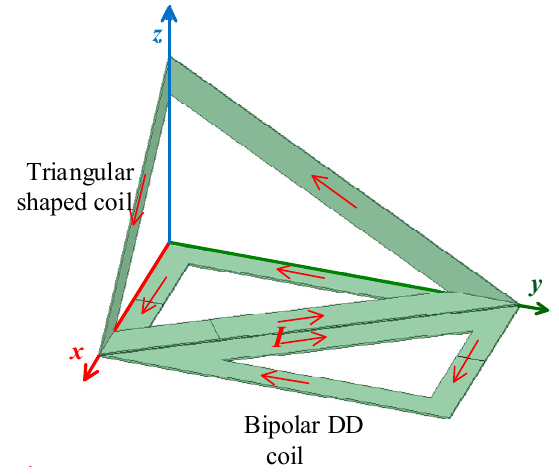
Figure 1. Configuration of the proposed 3D Tx coil.